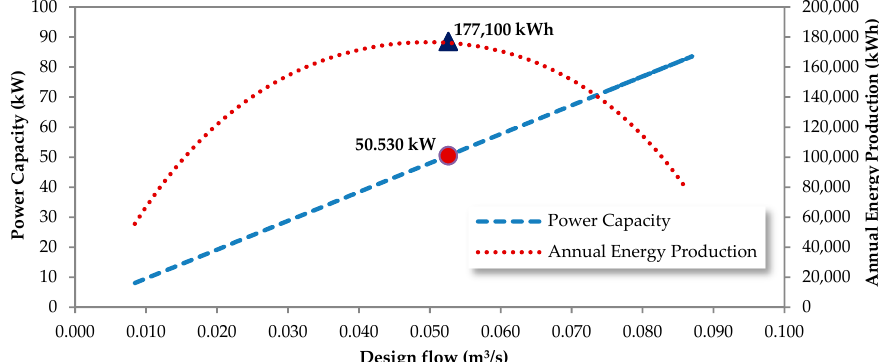
Figure 12. Comparison between the power capacity and annual energy production of the result of the second phase of the algorithm (Figure 10) in 200 classes.